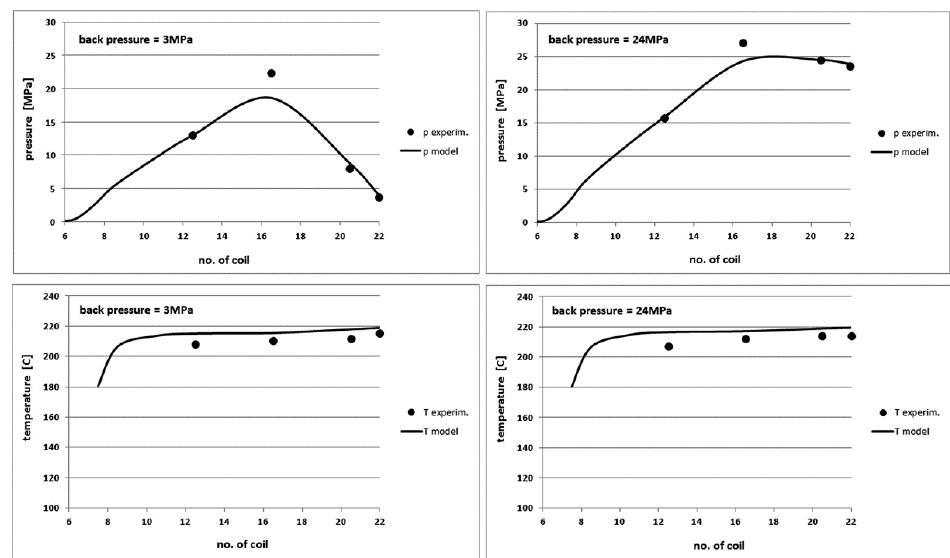
Figure 8. Comparison of theoretical and experimental characteristics of pressure ( top ) and temperature profiles ( bottom ) on the screw channel length in POM injection process for the back pressure of 3 MPa ( left ) and 24 MPa ( right ).